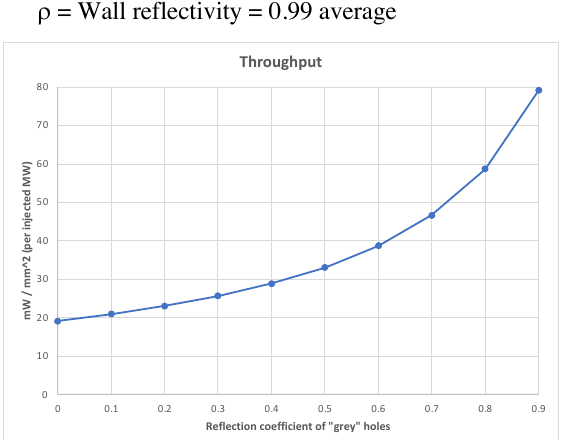
Fig. 11 . Output flux (throughput) from a small opening as function of “grey” hole’s reflection coefficient